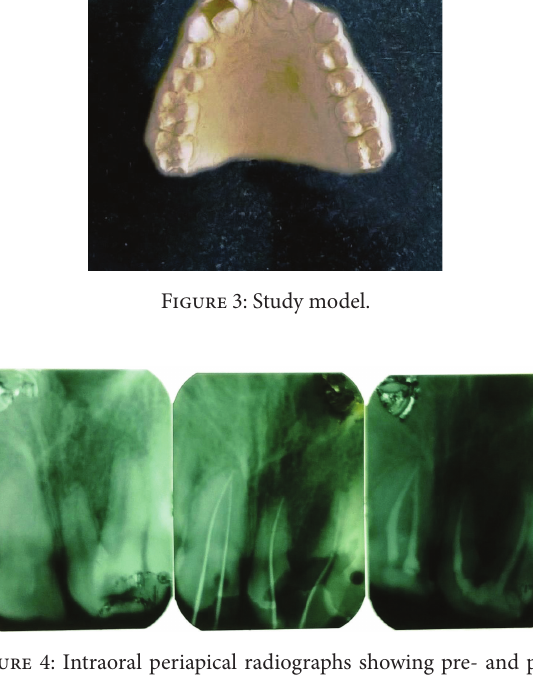
Figure 4: Intraoral periapical radiographs showing pre- and pos- tendodontic